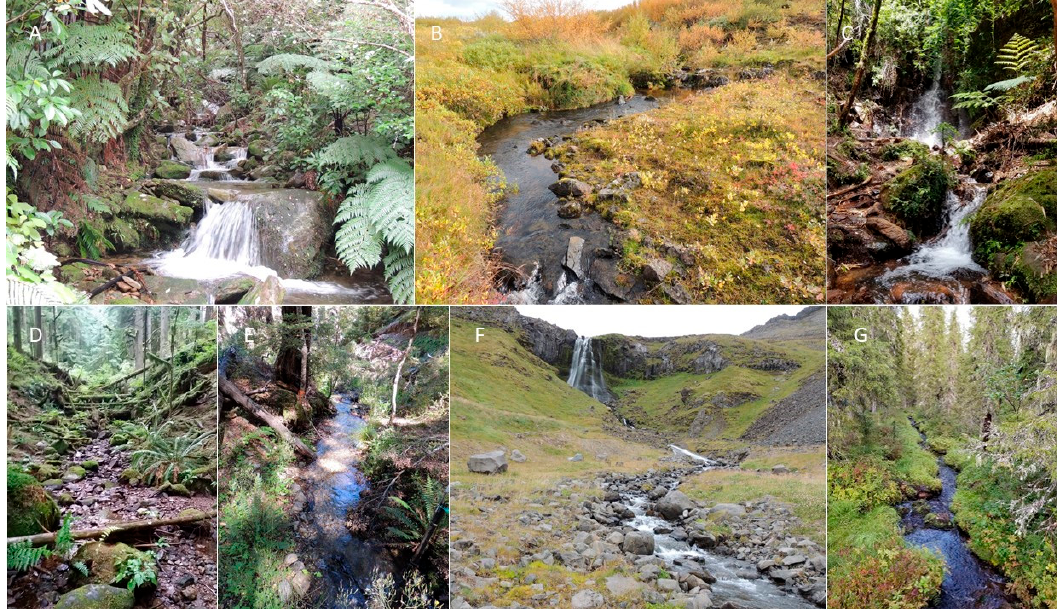
Figure 1. Examples of headwater streams in different biomes: ( A ) near Marlborough Sound, New Zealand; ( B ) Iceland near Hlauptungufoss; ( C ) near Caleta Chaihuín, Chile; ( D ) East Creek, Malcolm Knapp Research Forest, British Columbia, Canada; ( E ) Middle Bush Stream, Cass, New Zealand; ( F ) near Grundarfjörður, Iceland; and ( G ) near Pudasjärvi, Finland.